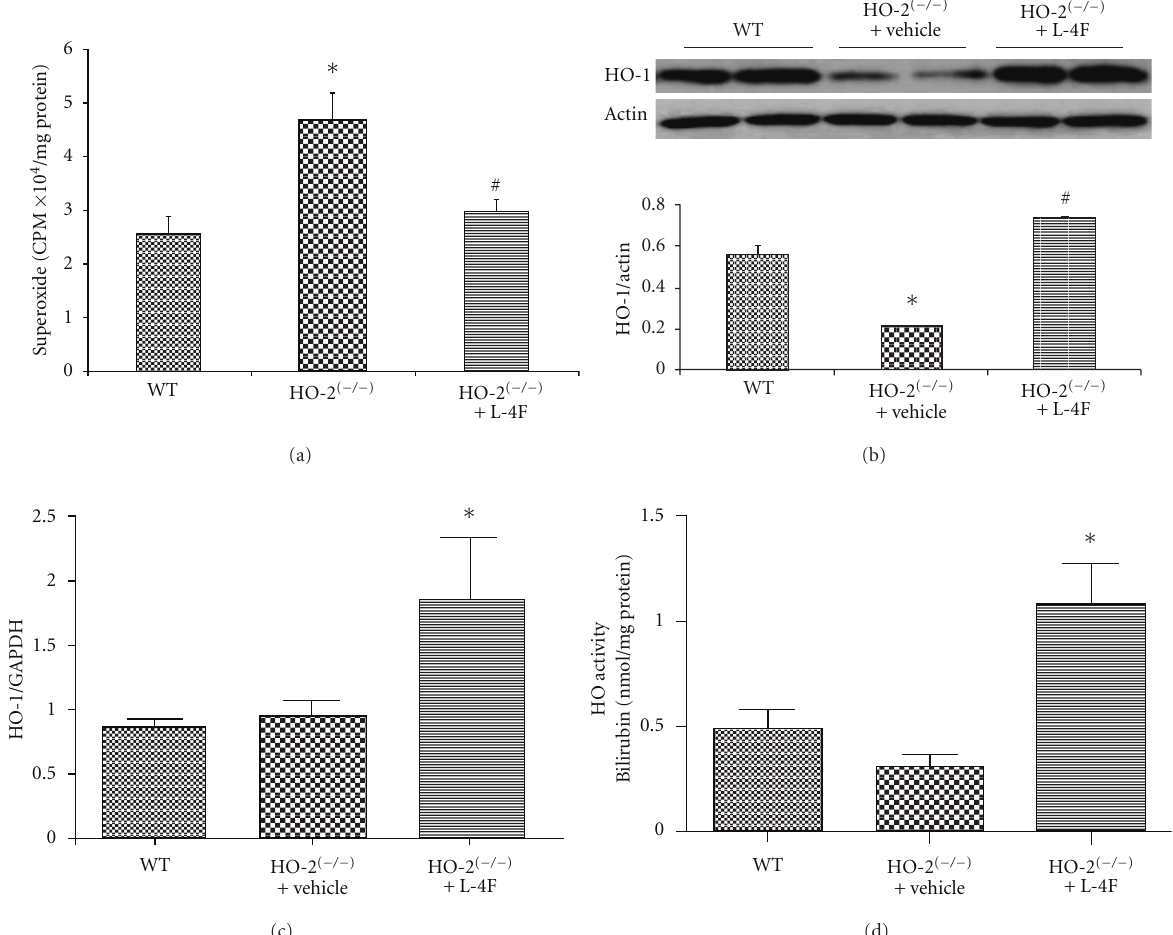
Figure 3: E ff ect of L-4F on redox status, HO-1 levels, and activity in HO-2 null mice. (a) Levels of superoxide produced in WT, HO-2 ( − / − ) and L-4F treated HO-2 ( − / − ) mouse liver. Values are means ± SE, n = 6, ∗ P < 0 . 05 versus WT, and # P < 0 . 05 versus HO-2 ( − / − ) . (b) Western blot, densitometry analysis and (c) mRNA expression of hepatic tissues for HO-1 expression. Values are means ± SE, n = 6, ∗ P < 0 . 05 versus WT, # P < 0 . 05 versus HO-2 ( − / − ) (d). E ff ects, L-4F on HO-1 activity measured as described in materials and methods. Results are means ± SE, n = 6, ∗ P < 0 . 05 versus HO-2 ( − / − )